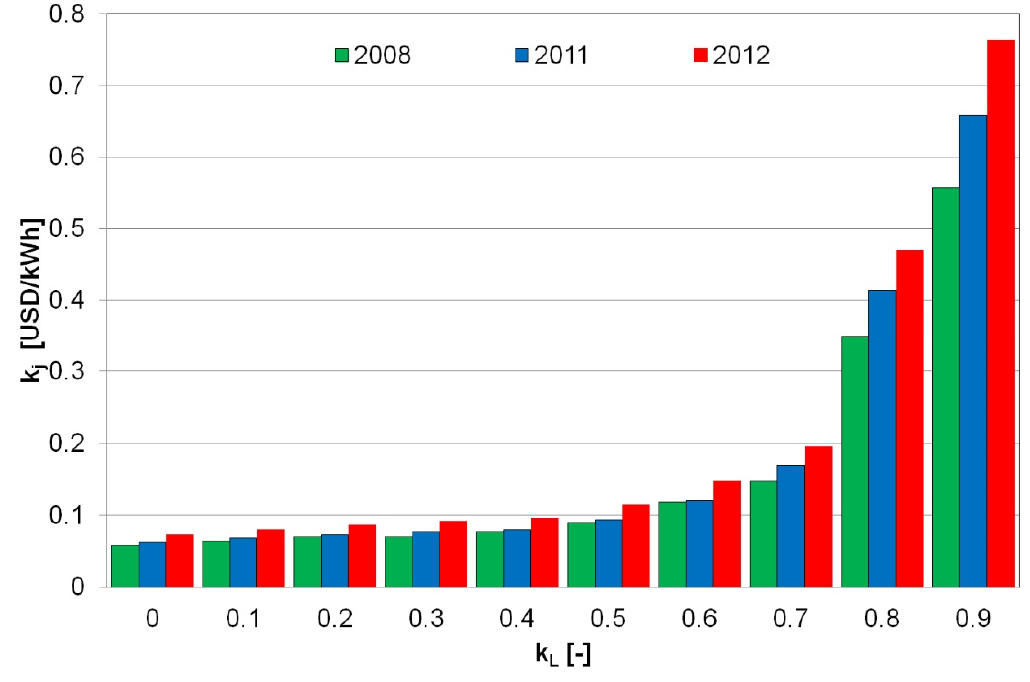
Figure 7. Values of the discounted unit cost of energy production in the optimised WPP-FESS system as a function of the ratio of elimination of allowable interruptions k L for 2008, 2011 and 2012.